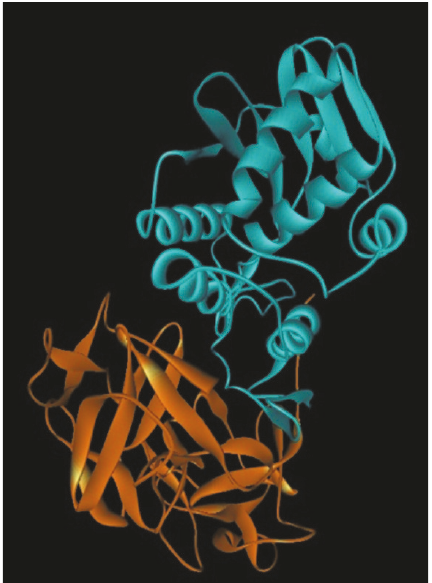
Figure 7: The molecular structure of ricin.